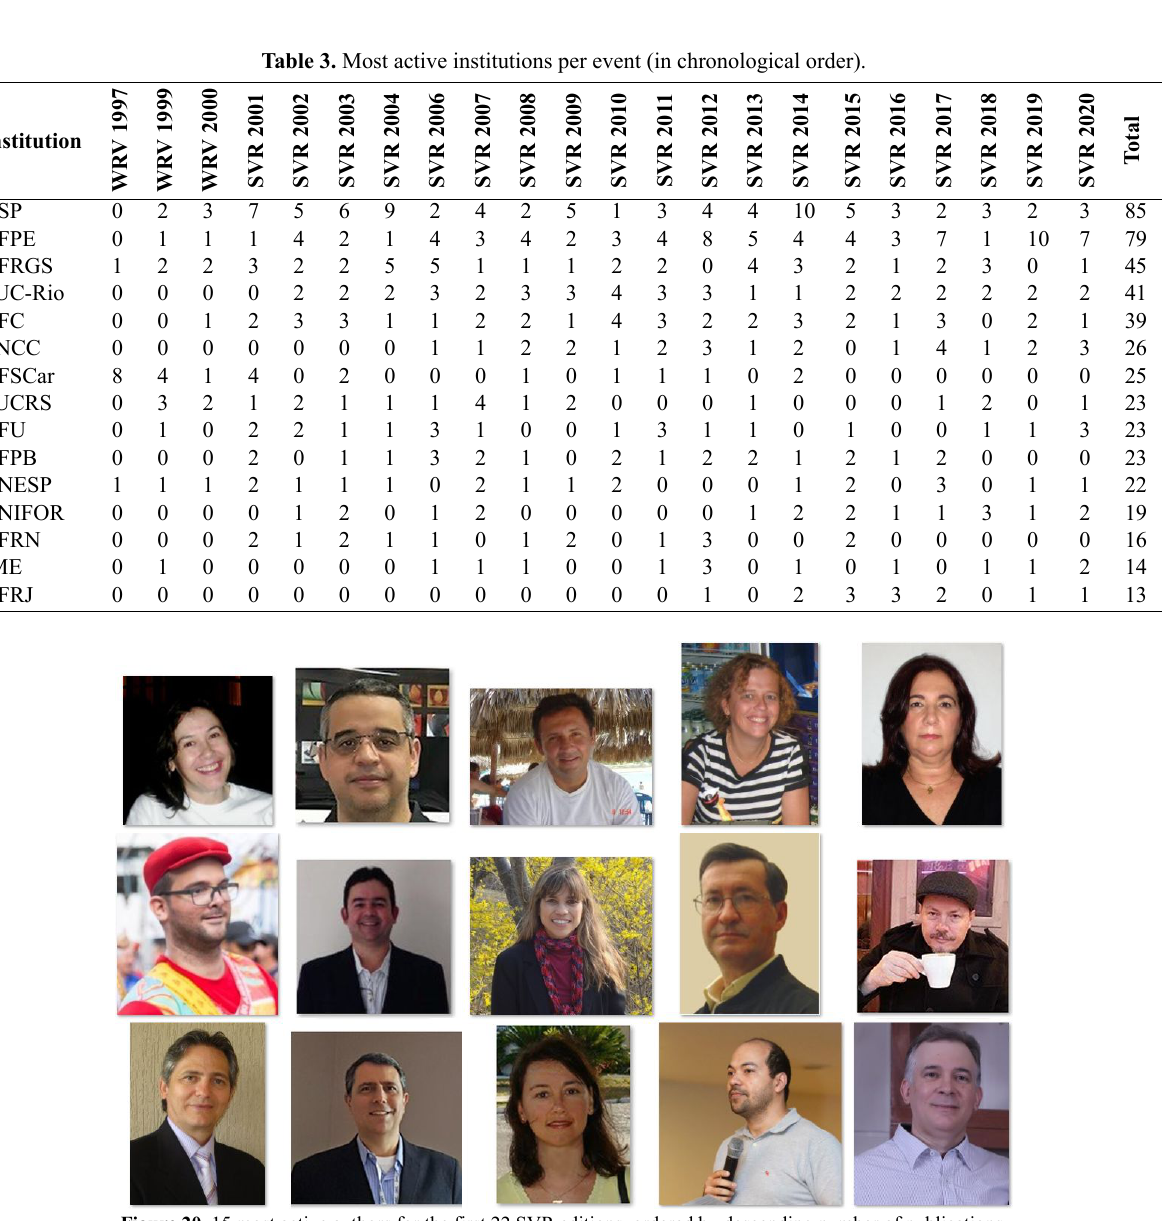
Figure 20. 15 most active authors for the first 22 SVR editions, ordered by descending number of